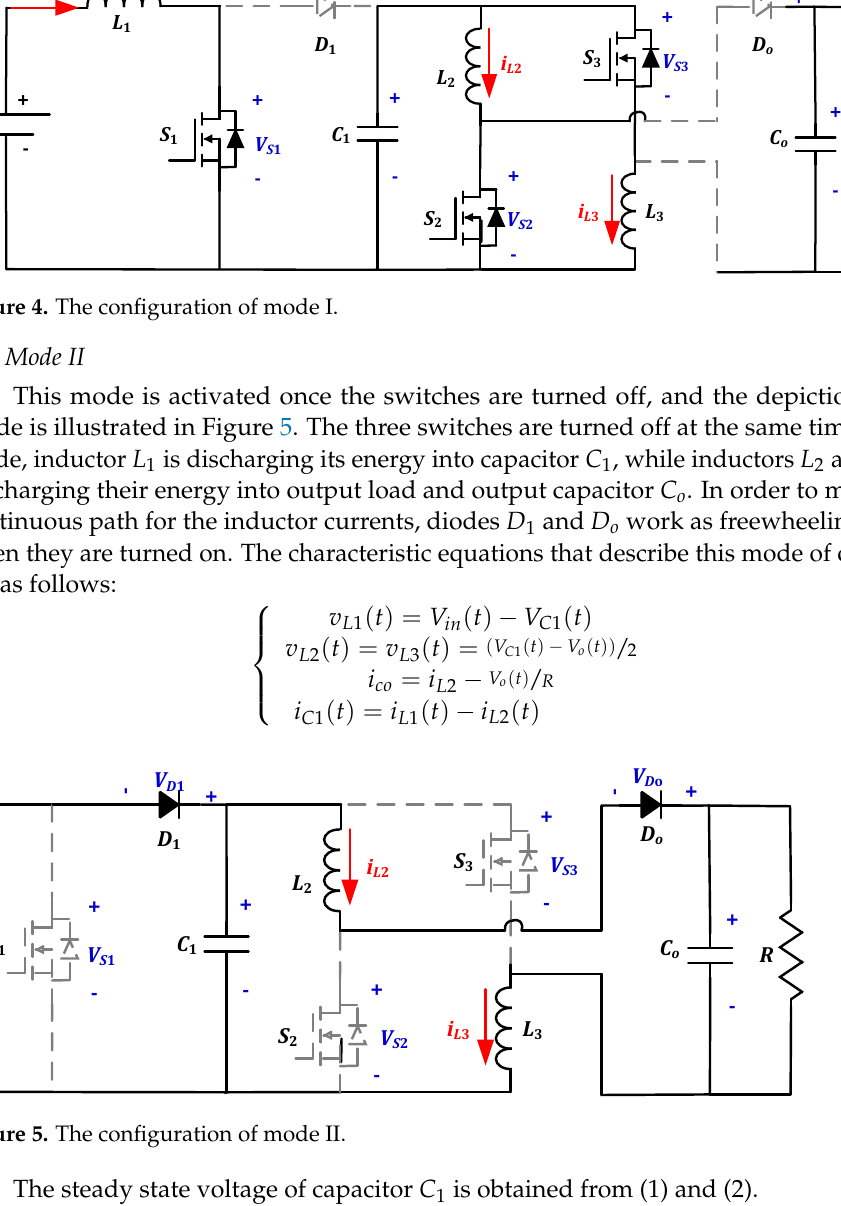
Figure 3. The ideal key waveforms of the converter. 2.1. Mode I